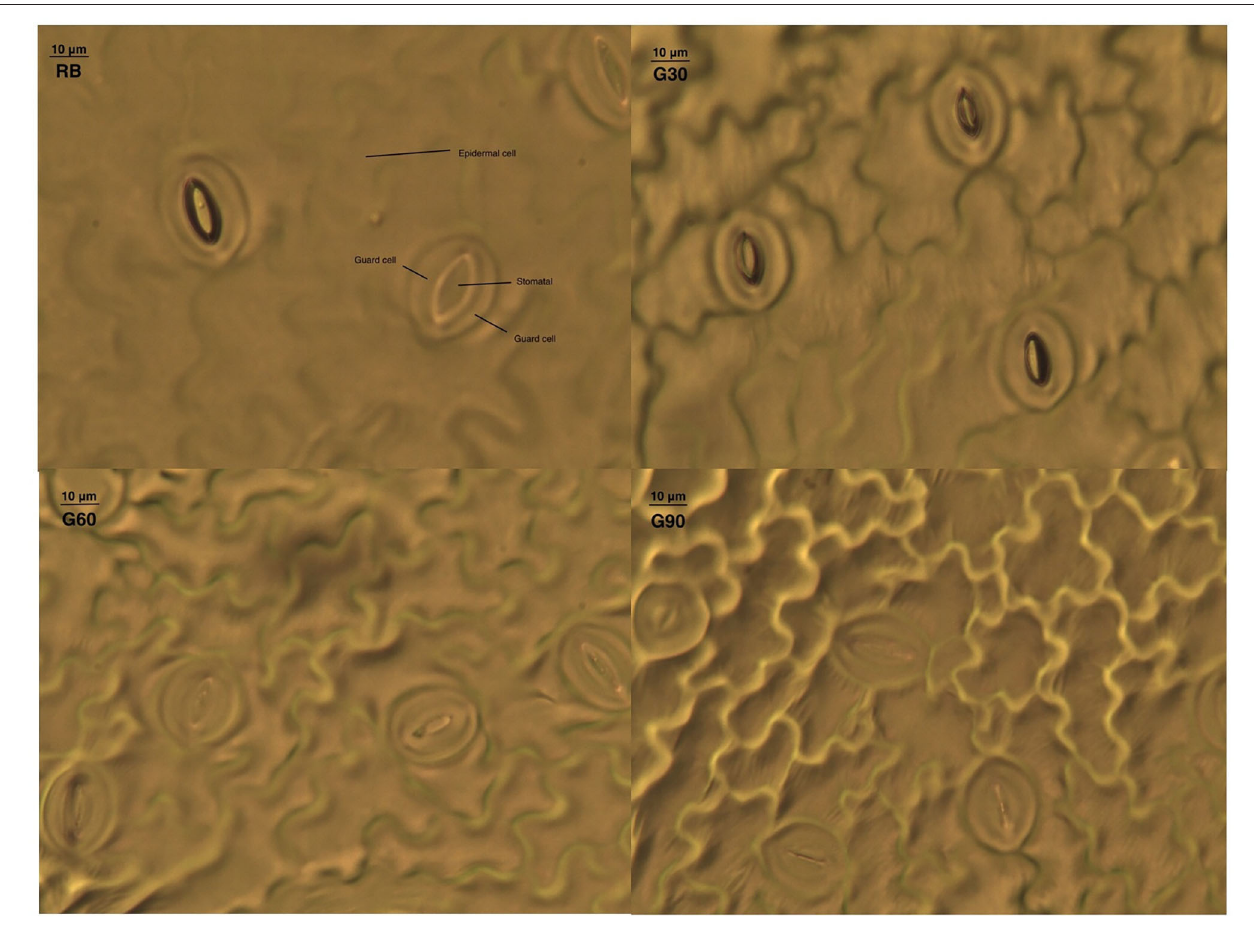
FIGURE 5 | Photos of stomatal characteristics under the different proportions of green light.